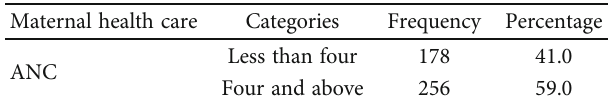
Table 3: The prevalence of maternal health care in the South Gondar